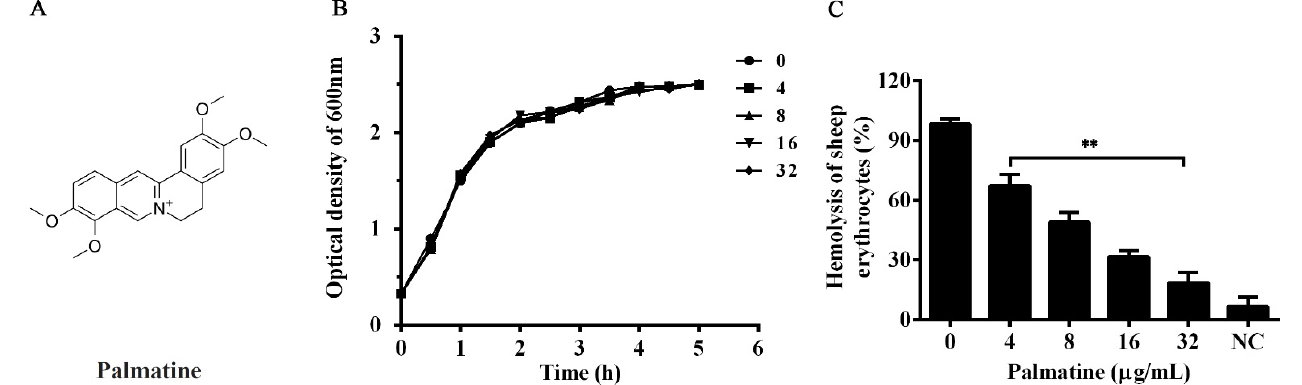
Figure 1. Inhibitory effect of palmatine on hemolysis induced by aerolysin in bacterial supernatants. ( A ) Chemical structure of palmatine. ( B ) Growth curves of A. hydrophila XS-91-4-1 co-cultured with different concentrations of palmatine. Values of each data point are the averages of three independent experiments. ( C ) Hemolytic activity of A. hydrophila culture supernatants treated with increasing concentrations of palmatine. Hemolysis of 1% Triton-X-100-treated sheep red blood cells served as the positive control, whereas hemolysis of bacterial supernatant without trypsin treatment served as the negative control (NC). Values represent the mean and standard deviation of three independent assays. Statistical significance was determined by Student’s t -test; ** indicates p < 0.01.